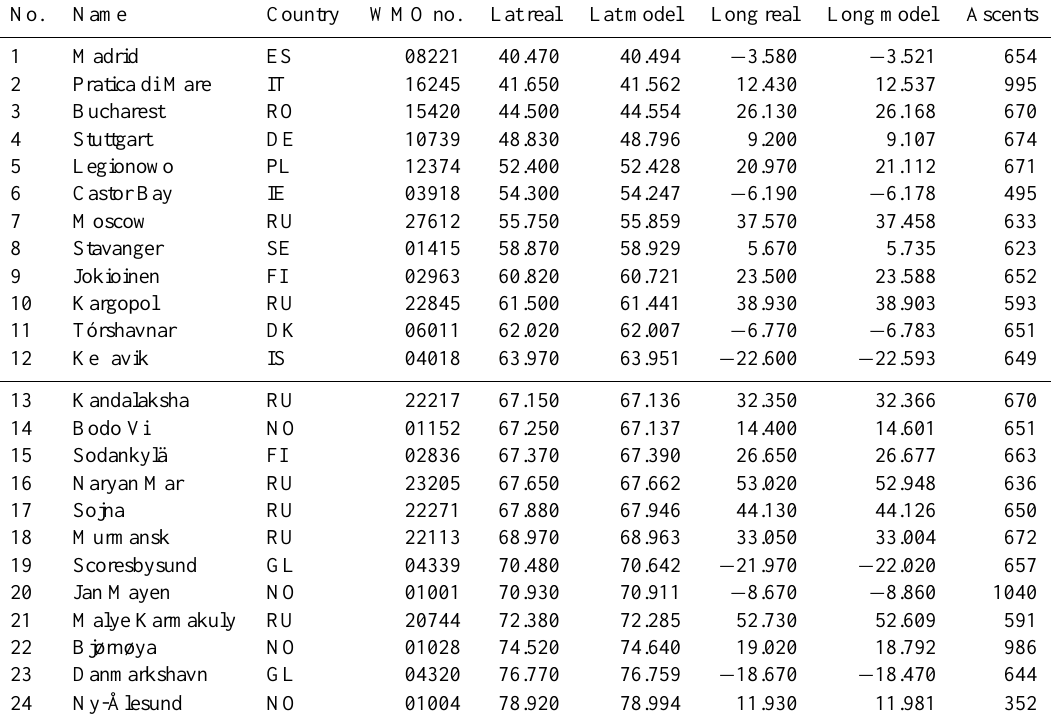
Table B1. Specifications of the stations from which data were used in this study. Stations 1–12 are in temperate latitudes, 13–24 in polar latitudes. The international country code is also given. Real coordinates are those of the true location, model coordinates those of the closest grid point used to compare measurements and model